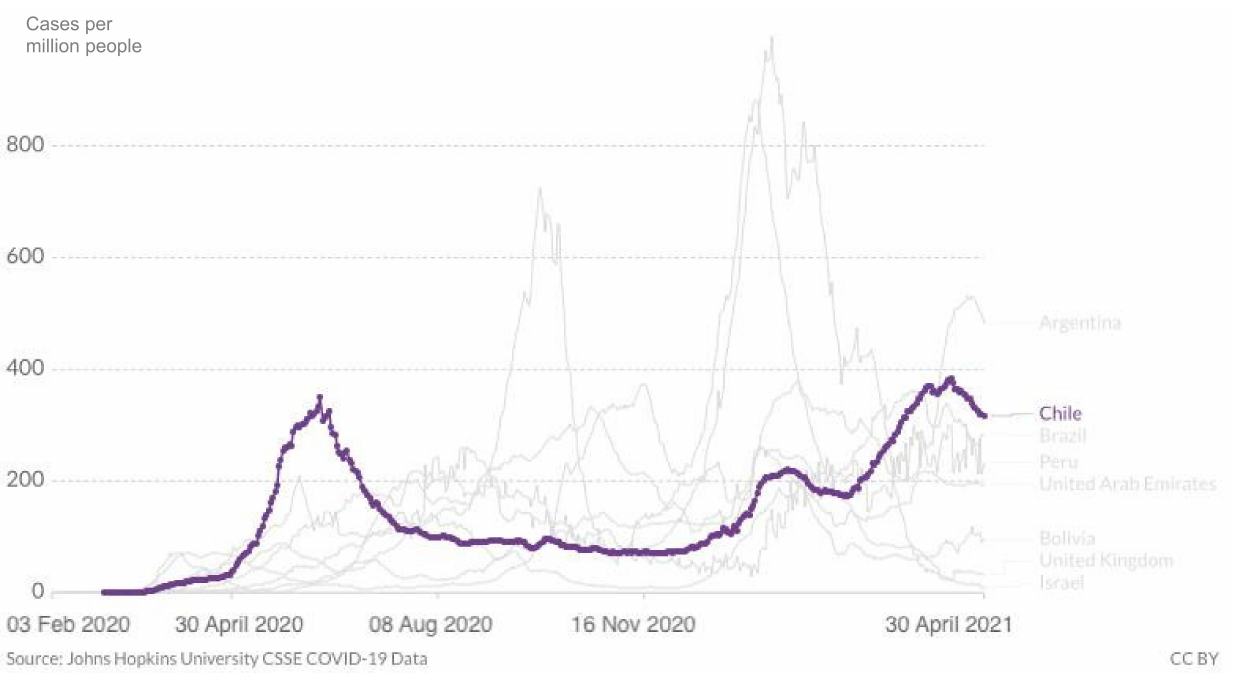
Figure 1. Number of daily new confirmed COVID-19 cases per million people in Chile from the first notified case until 30 April 2021, including comparison with the region (Argentina, Brazil, Bolivia, Peru) and other leading vaccination nations (Israel, UAE, UK). www.ourworldindata.org (accessed on 1 May